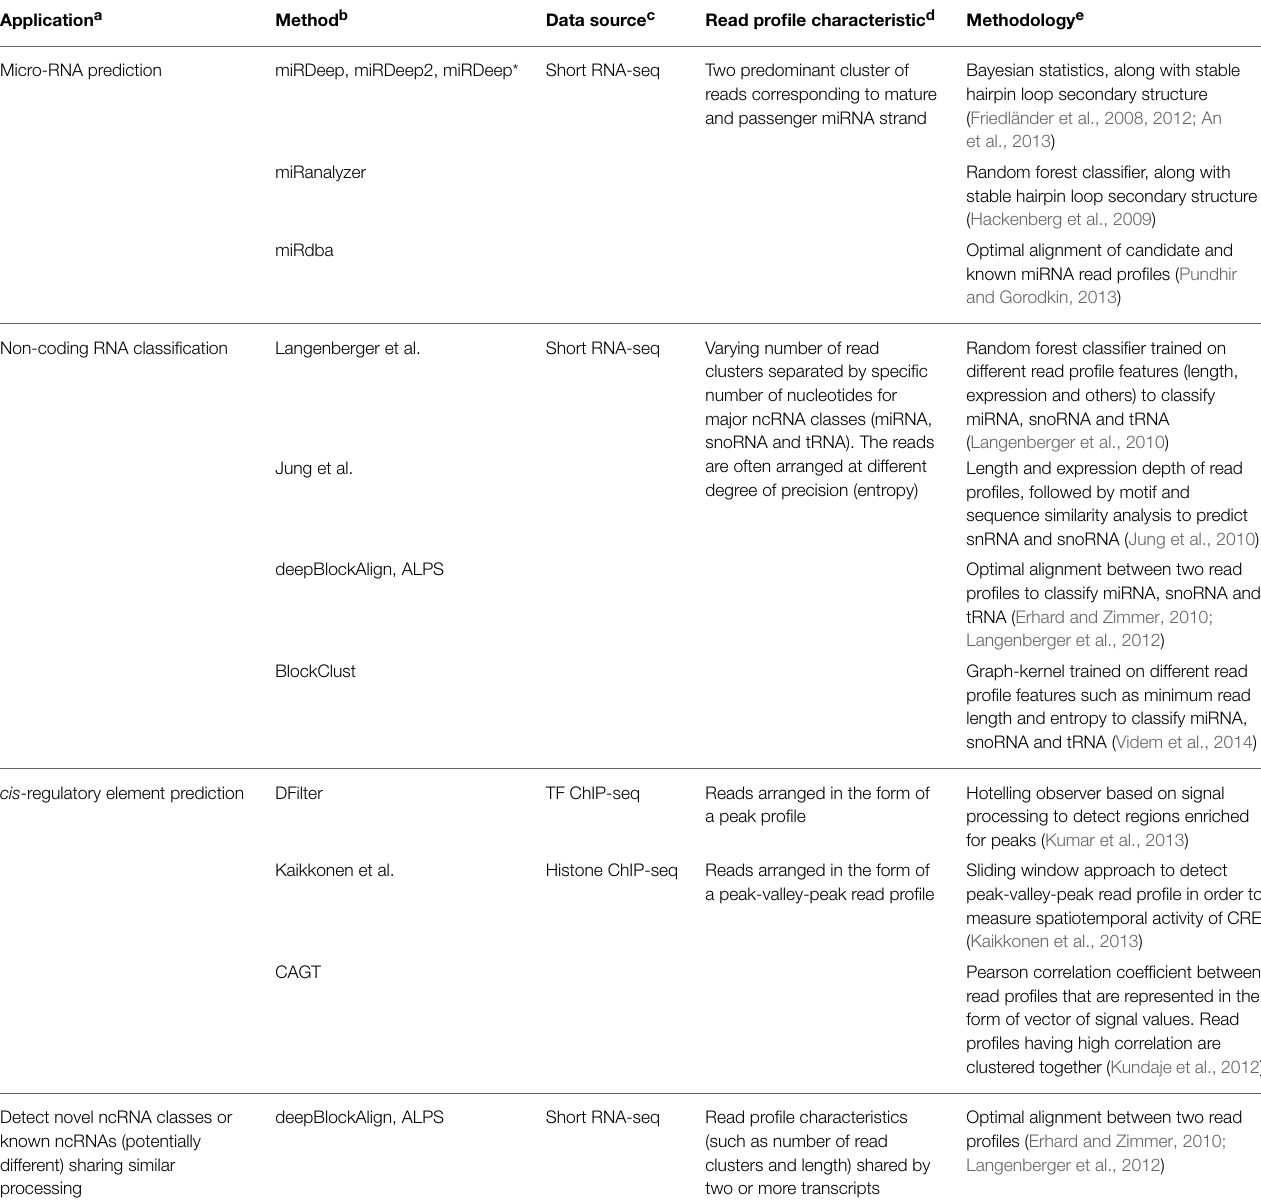
TABLE 1 | A brief summary of computational methods that use the concept of read profiles for the prediction of microRNA (miRNA), non-coding RNA (ncRNA) and cis -regulatory elements